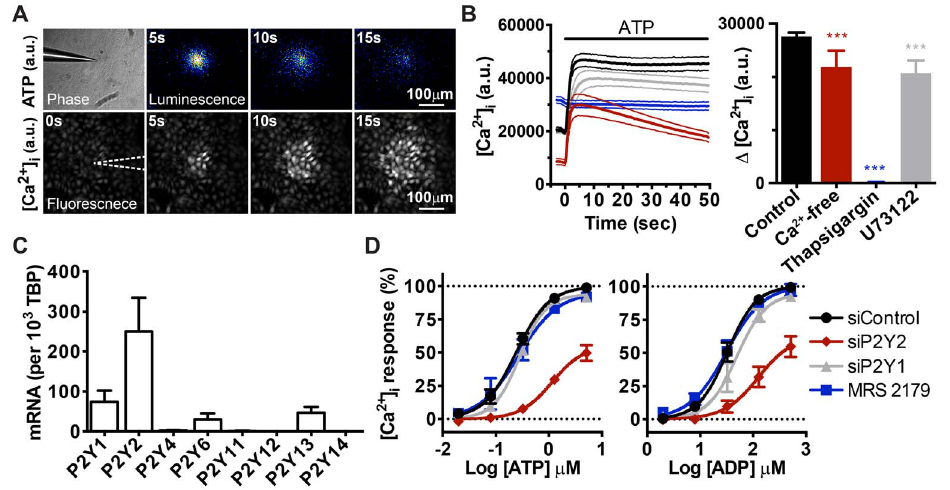
Figure 3. ATP evokes [Ca 2 + ] i increase in HaCaT cells via P2Y2 receptor activation. (A) Visualization of extracellular ATP and intracellular calcium when one HaCaT cell was activated by mechanical force. Images represent montages of ATP bioluminescence (upper panel) and intracellular calcium fluorescence (lower panel) after touching a cell with a glass needle. White dotted lines outline the position of glass needle (a.u., arbitrary unit). (B) The kinetics (left) and amplitude (right) of the [Ca 2 + ] i increase when HaCaT cells were pre-incubated in Ca 2 + -free HBSS (red line), 1 m M thapsigargin (blue line), 10 m M U73122 (gray line), or untreated (black line), and stimulated with 5 m M ATP. Dotted lines indicate SD. Bars denote the amplitudes of the increases in the left panel (mean 6 SEM, n=8, one-way ANOVA followed by Dunnett’s multiple comparison test, *** p , 0.001, a.u., arbitrary unit). (C) The relative expression levels of eight P2Y receptor mRNAs in HaCaT cells, as evaluated using real-time PCR. Bars denote the mRNA levels expressed as copies per 10 3 TBP mRNAs. (D) ATP- and ADP-evoked [Ca 2 + ] i increases in HaCaT cells in which P2Y1 and P2Y2 were knocked down using siRNA or inhibited using the P2Y1-selective antagonist MRS 2179 (10 m M). Sigmoid curves denote the dose-response relationships of peak [Ca 2 + ] i increases to various concentrations of ATP and ADP. Values are normalized to the maximal response of siControl (mean 6 SEM, n=2 to